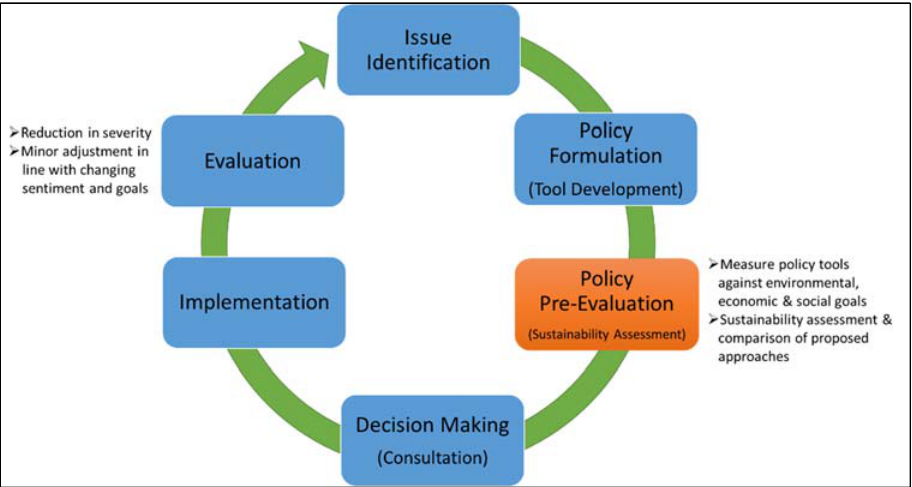
Figure 4. Revised energy policy making process.